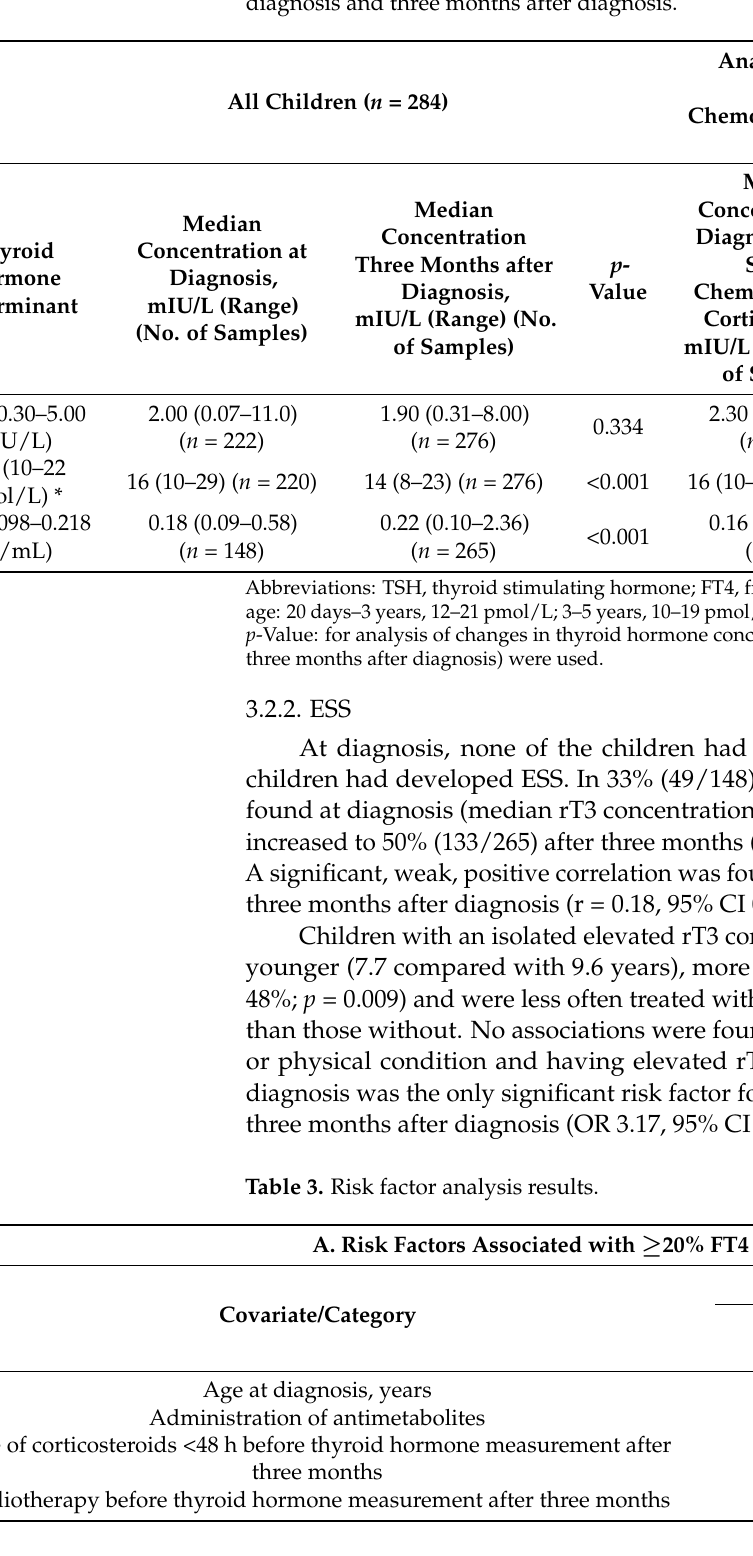
Table 2. Median plasma concentration of thyroid determinants in children with cancer measured at diagnosis and three months after diagnosis.